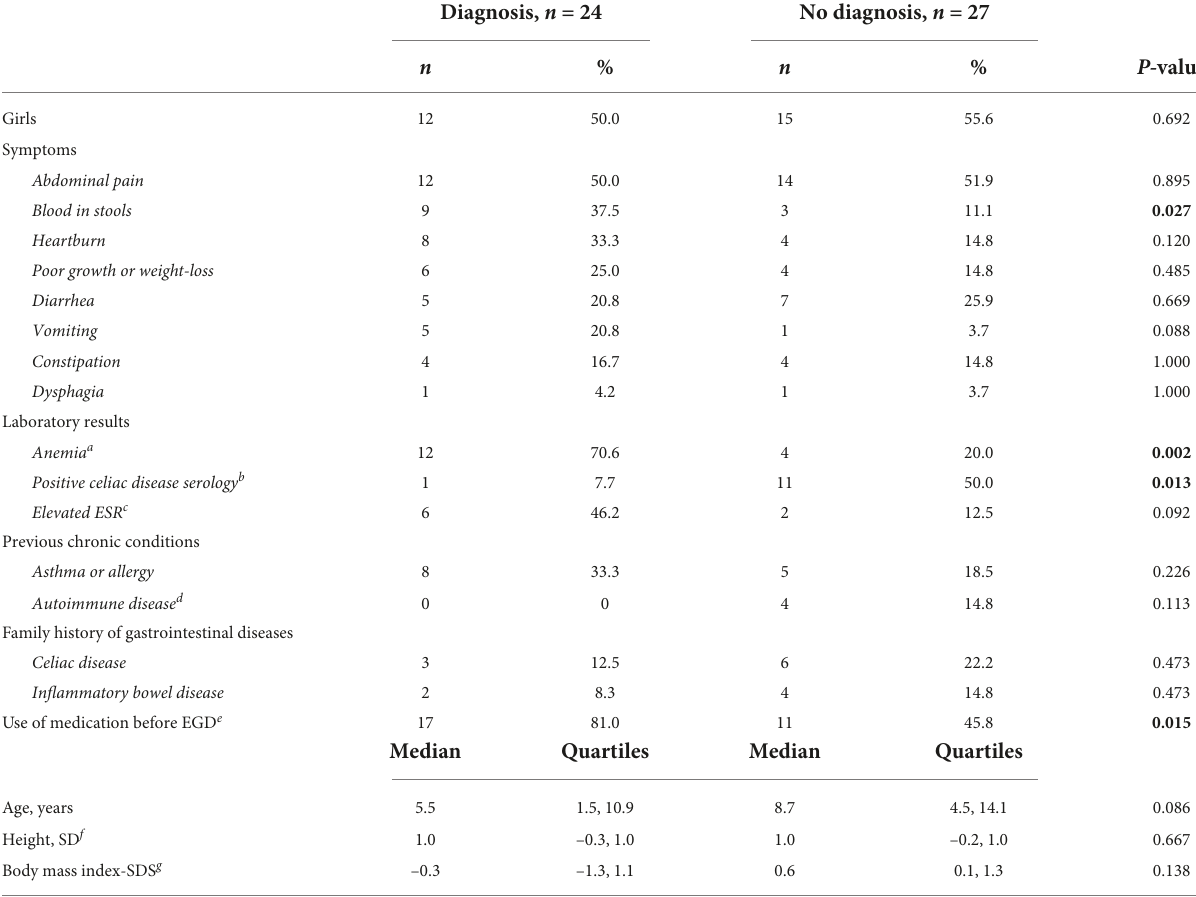
TABLE 2 Comparison of clinical characteristics at the time of first esophagogastroduodenoscopy (EGD) between children who had non-atrophic duodenal changes and did and did not receive a diagnosis. Diagnosis, n =